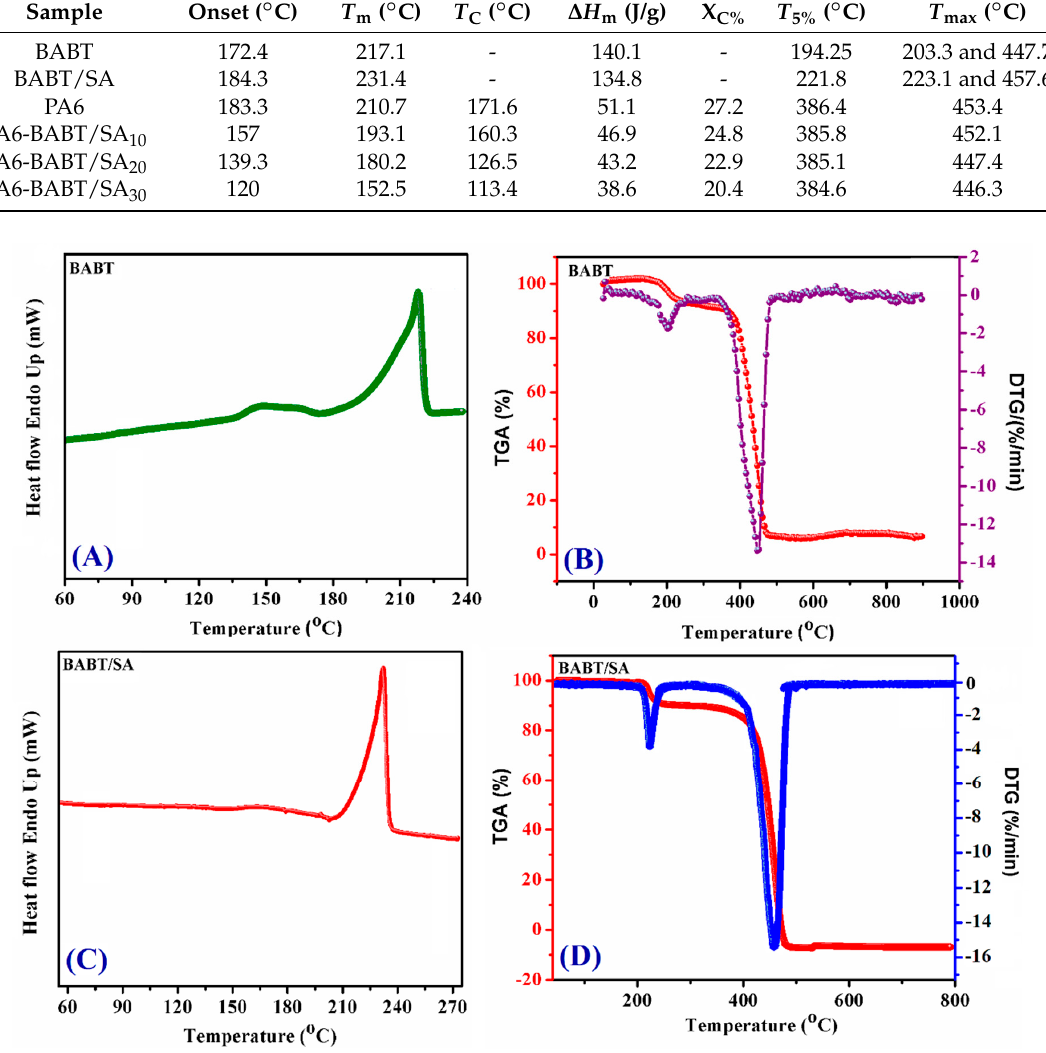
Table 4. Thermal properties and the calculated crystallization degrees of PA6 and PA6-BABA/SA copolyamides.